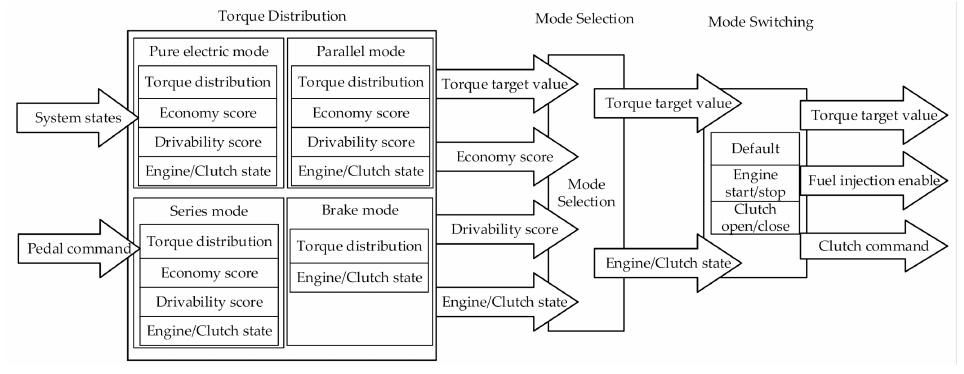
Figure 7. Powertrain control